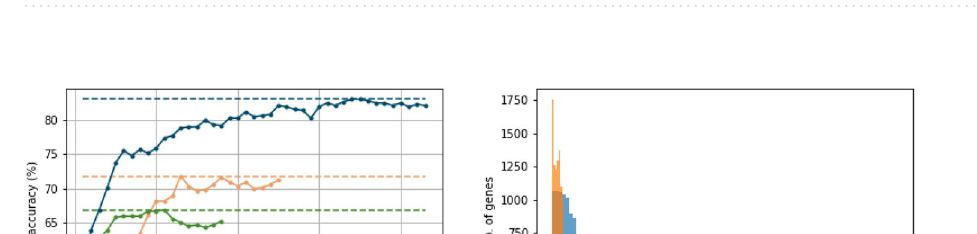
Table 2. Performance of individual (binary) models for each cancer type in terms of test accuracy and MAUC.